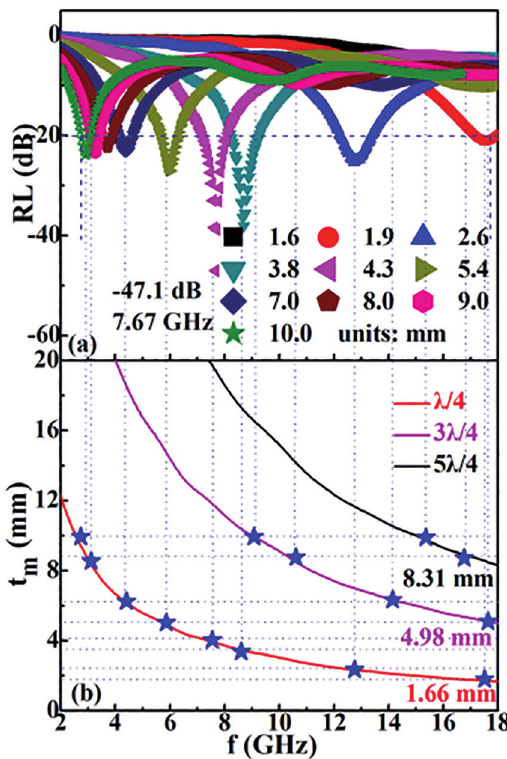
Figure 5: (a) dependence of RL on frequency at various thickness and (b) dependence of λ/4, 3λ/4 and 5λ/4 on frequency for the NiFe nanosheets-paraffin composite from its ε